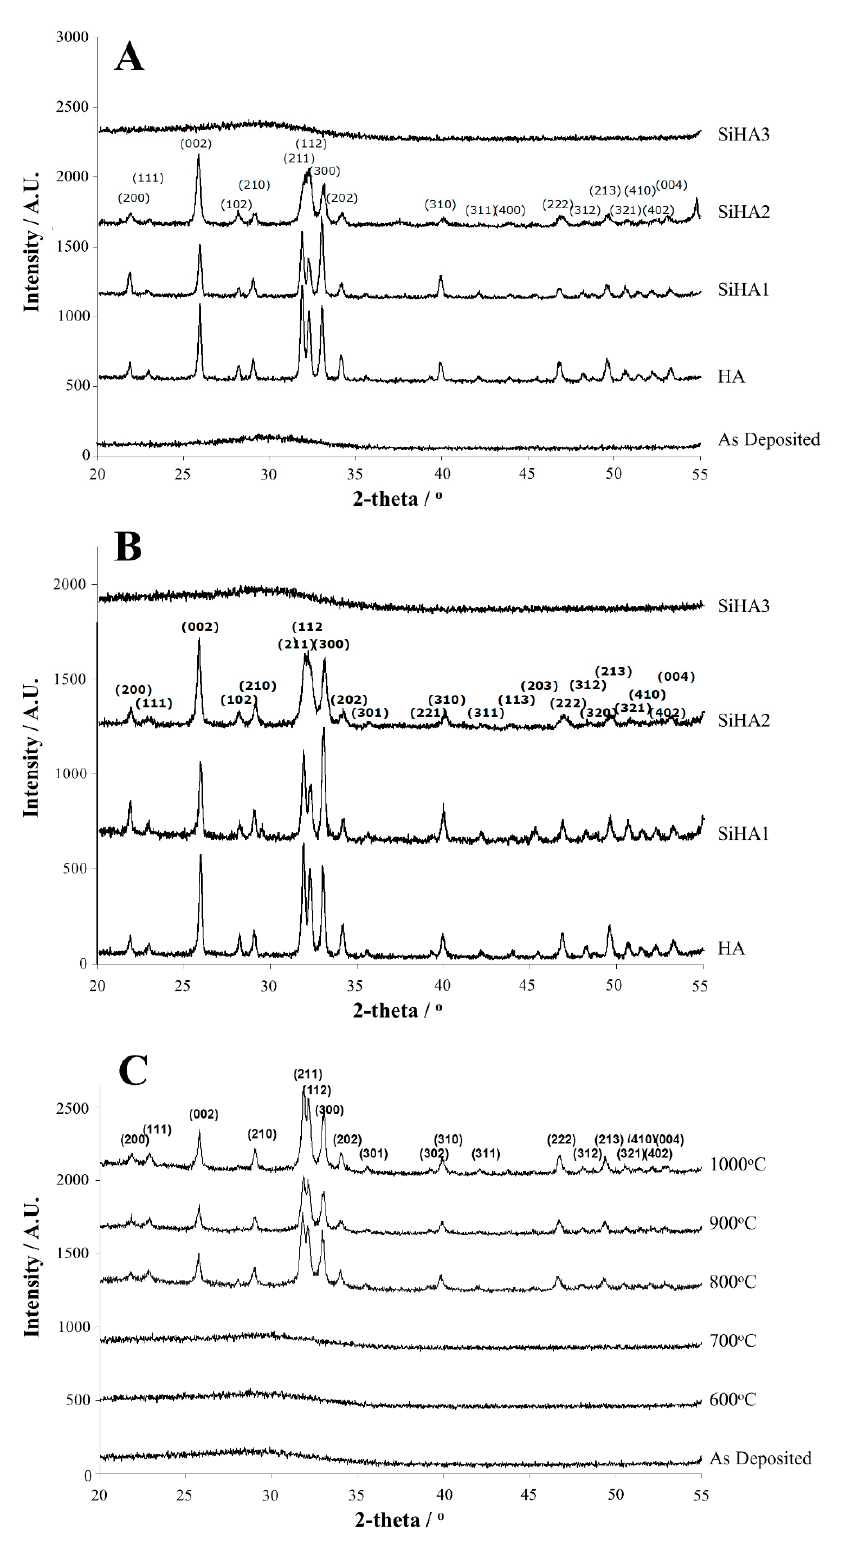
Figure 3. ( A ) and ( B ) Representative XRD plots of as deposited HA (unannealed), and HA and SiHA thin films on silicon (100) wafers heat treated at 600 °C and 700 °C in argon, respectively. ( C ) XRD plots of successive heat treatments on SiHA3 on silicon (100) wafer. Planes refer to ICDD 09-432 HA In addition, approximate crystallite size was calculated using the Scherrer equation. Table 1 lists calculated crystallite sizes of annealed HA and SiHA thin films from the XRD data presented. The